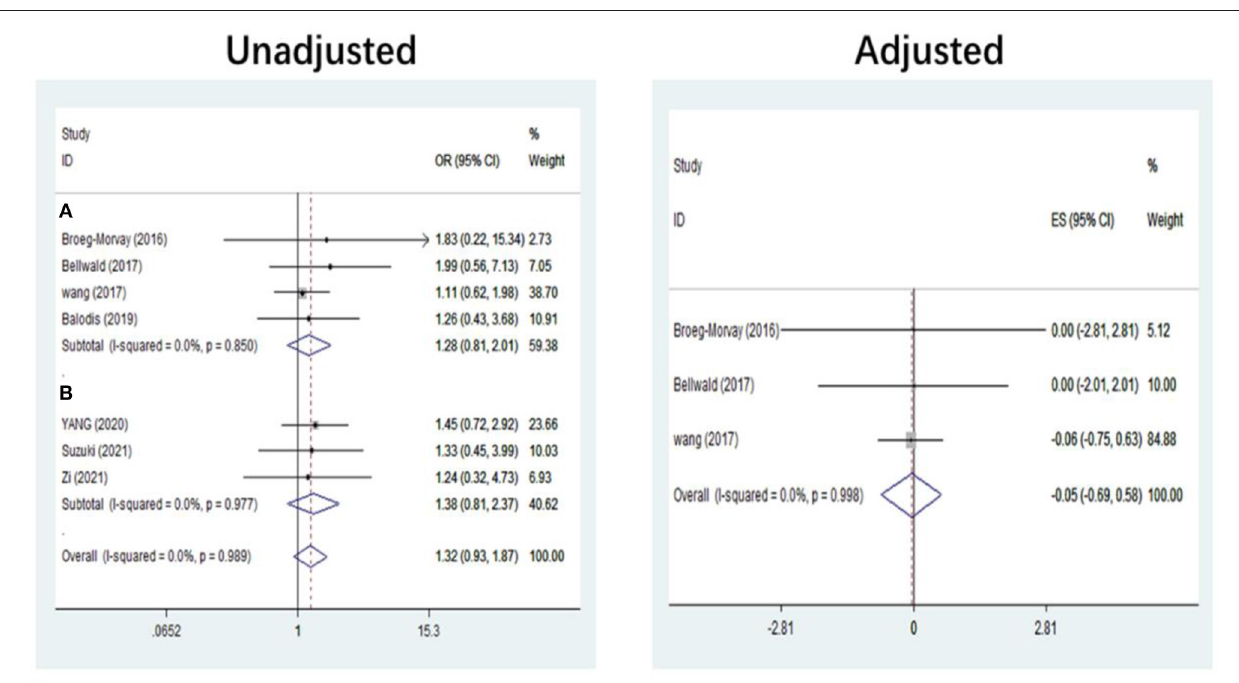
0.93, 95% CI = 0.68–1.28). In studies including IVT-ineligible patients in direct EVT, patients undergoing direct EVT tended to have lower rates of functional independence and higher odds of a